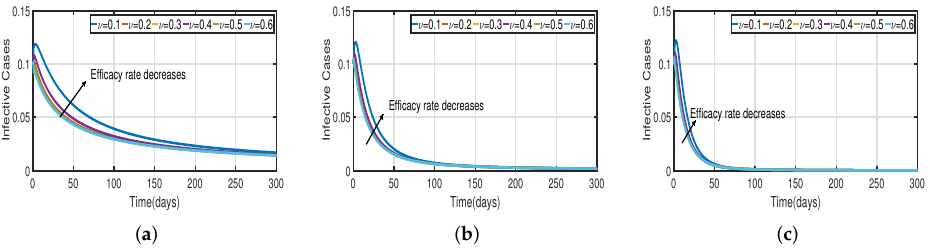
Figure 7. The trend of infected individuals regarding different vaccination efficacy rates ν . ( a ) Fractional-order α = 0.62. ( b ) Fractional-order α = 0.83. ( c ) Fractional-order α = 0.94. Daily COVID-19 cases in the UAE were considered for the time period from 25 March to 30 July 2020 for the population without vaccination, from 15 July 2021 to 15 December 2021 for a 50% vaccinated population, and from 15 January 2022 to 20 May 2022 for a 100% vaccinated population. The daily COVID-19 updates were obtained from